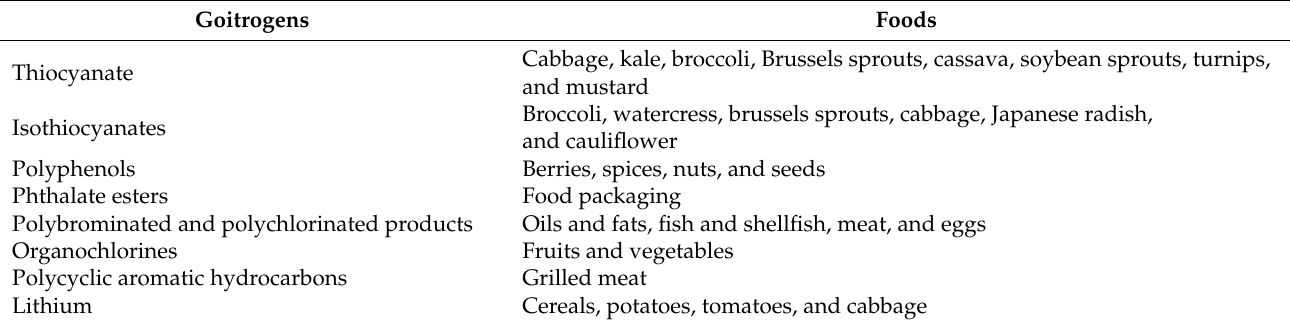
Table 1. List of foods containing goitrogenic